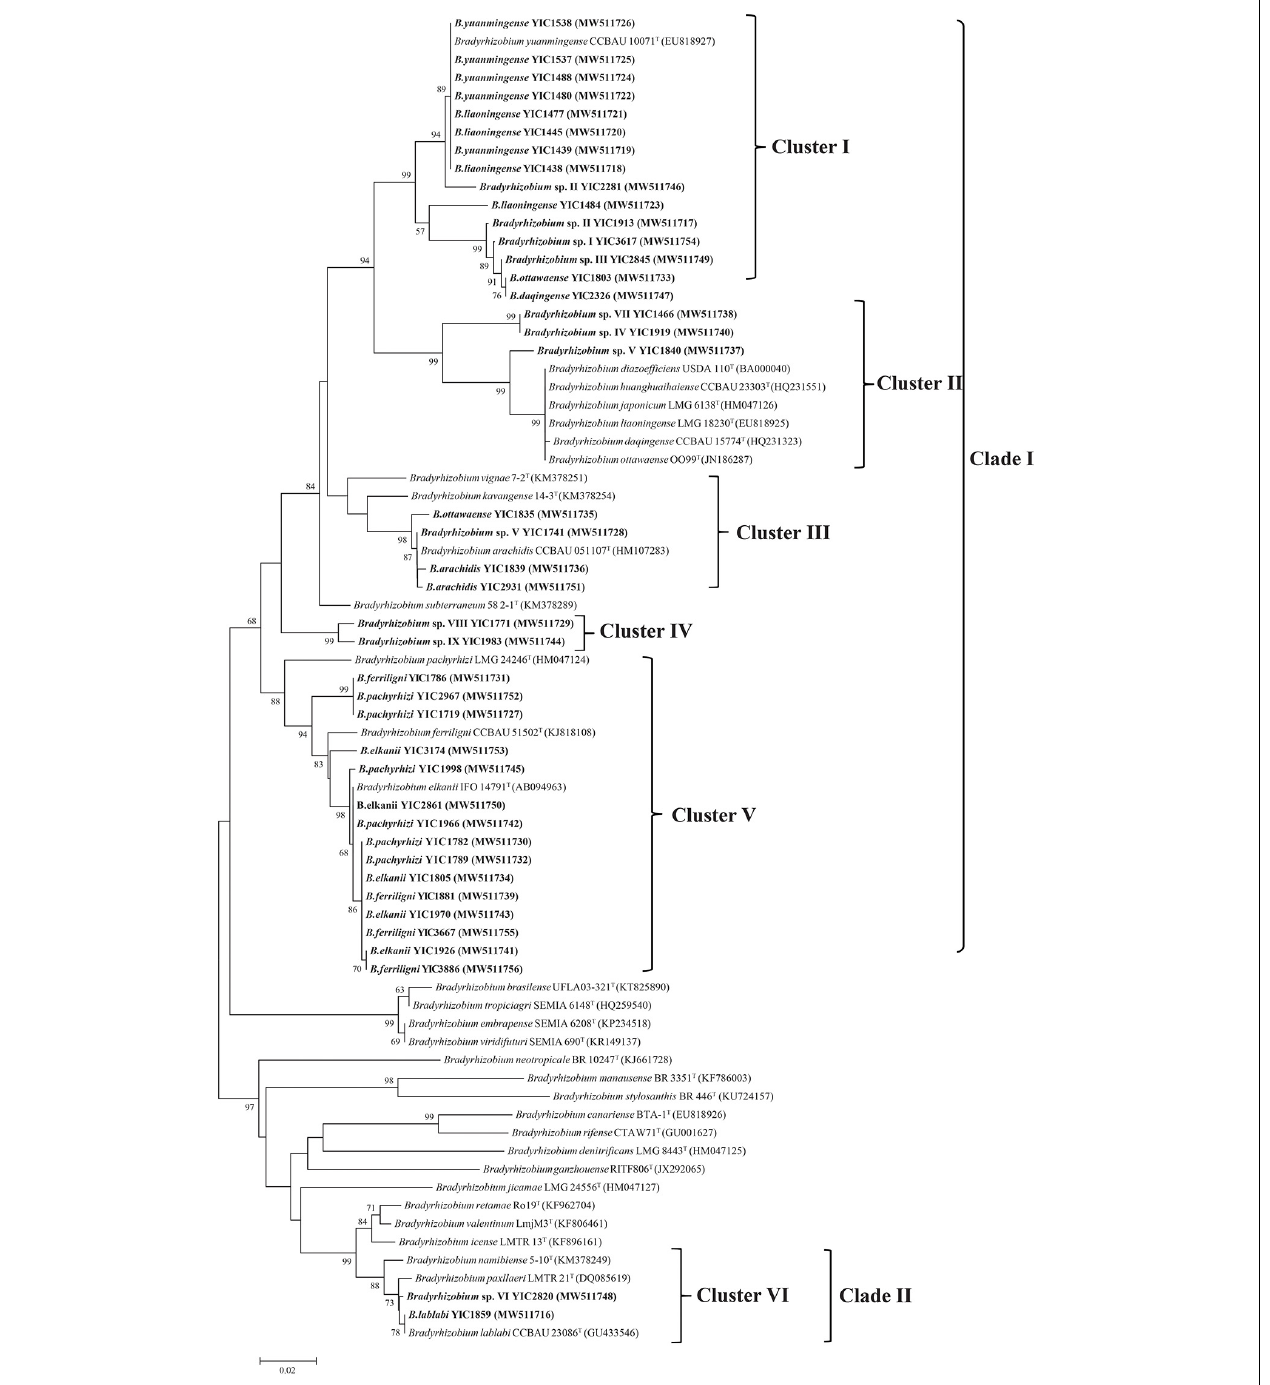
FIGURE 4 | Neighbor-joining tree based on nifH sequences of representative strains isolated in this study and reference strains. The tree was reconstructed using MEGA 7.0, and bootstrap values greater than 50% are shown at the nodes. The scale bar represents 2% nucleotide substitutions.